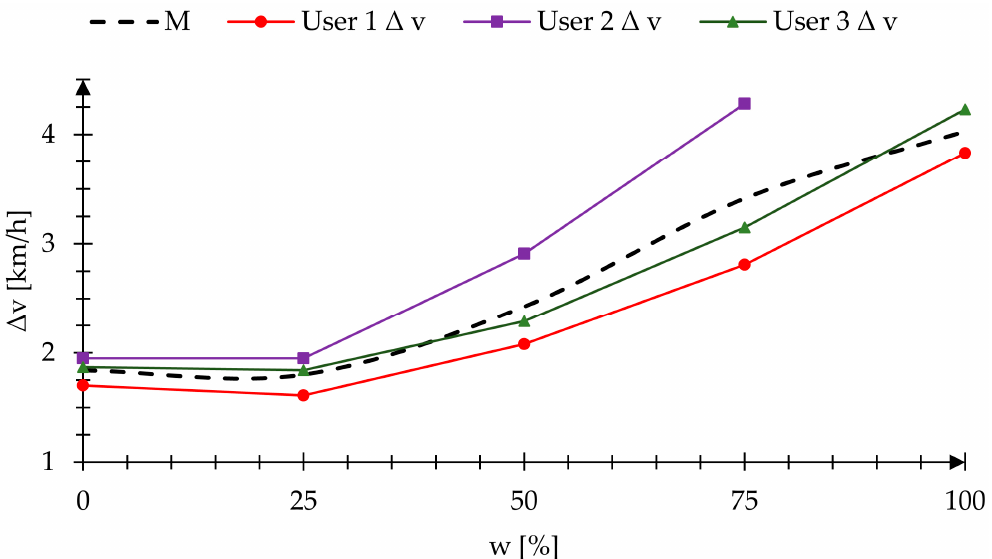
Figure 9. Graphs showing the maximum speed amplitude as a function of the assistance amplification coe ffi cient during the climb uphill as a function of the assistance amplification coe ffi cient for amplification of the driving torque mode